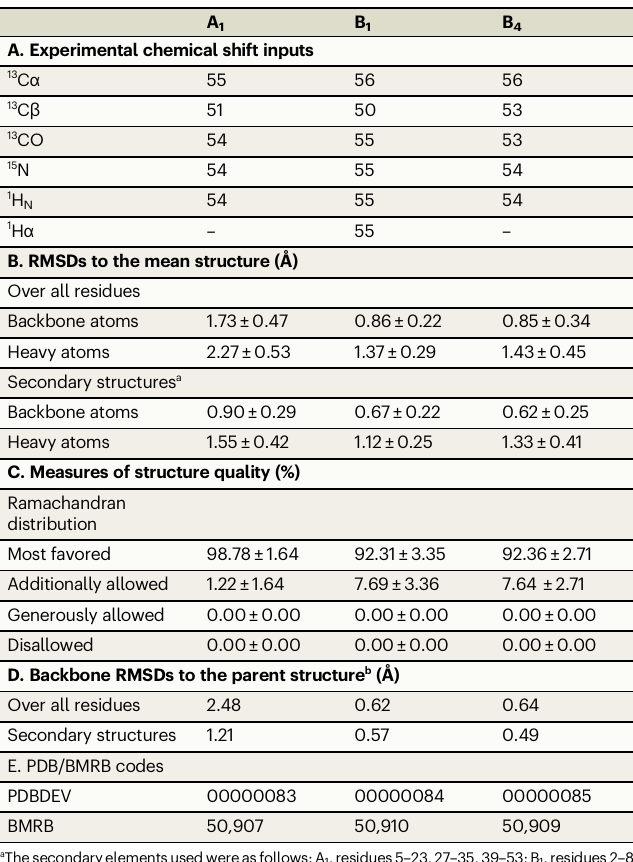
Table 2 | Structure statistics for S a1 , S b1 , S b2 , and S b3 Table 1 | Structure statistics for A 1 , B 1 , and B